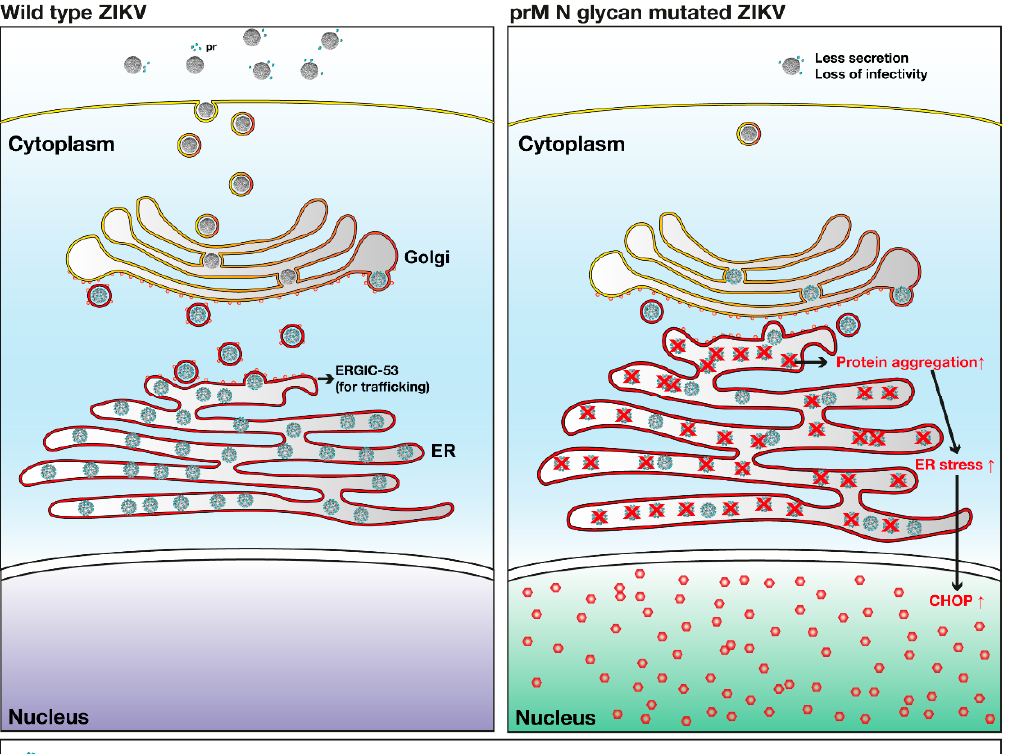
Figure 7. Hypothetical model of the role of N -glycosylation of the prM protein in ZIKV. Mutation in the